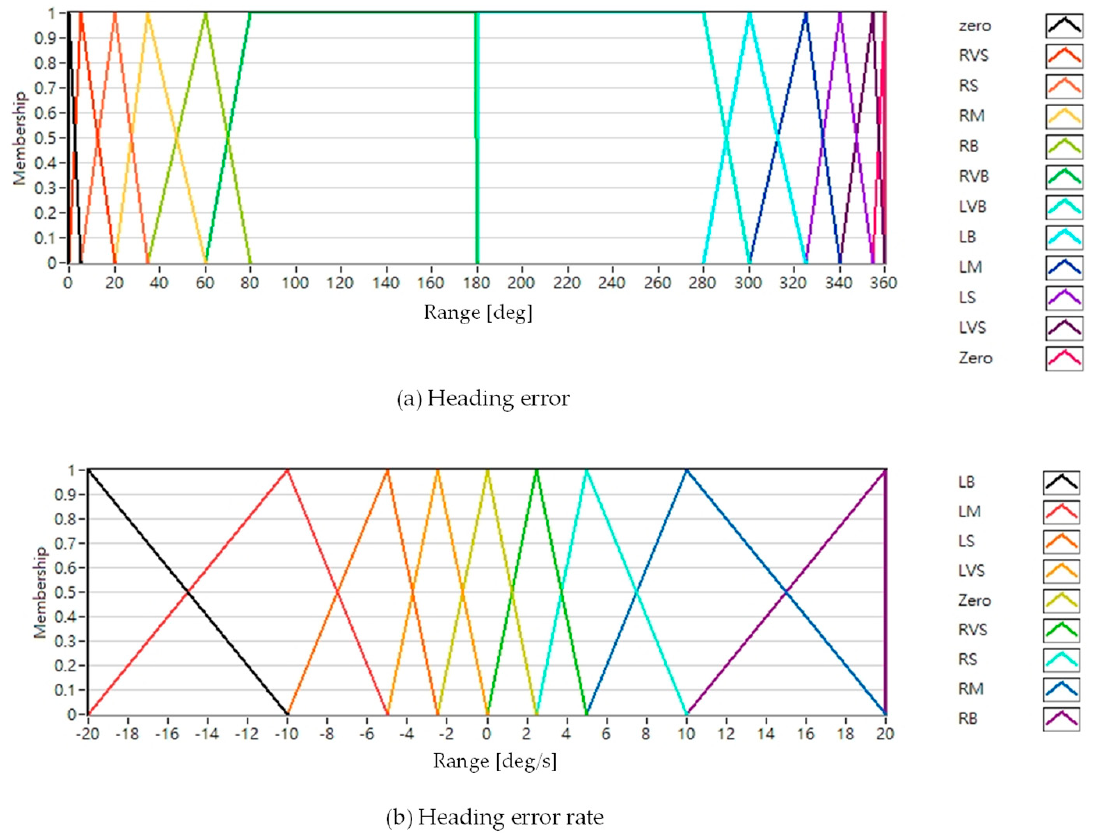
Figure 4. Fuzzy logic membership functions: ( a ) heading error and ( b ) heading error rate. The horizontal axis is the range of the error and error rate. The vertical axis is the membership function value. Table 1. Fuzzy rule database for heading control.